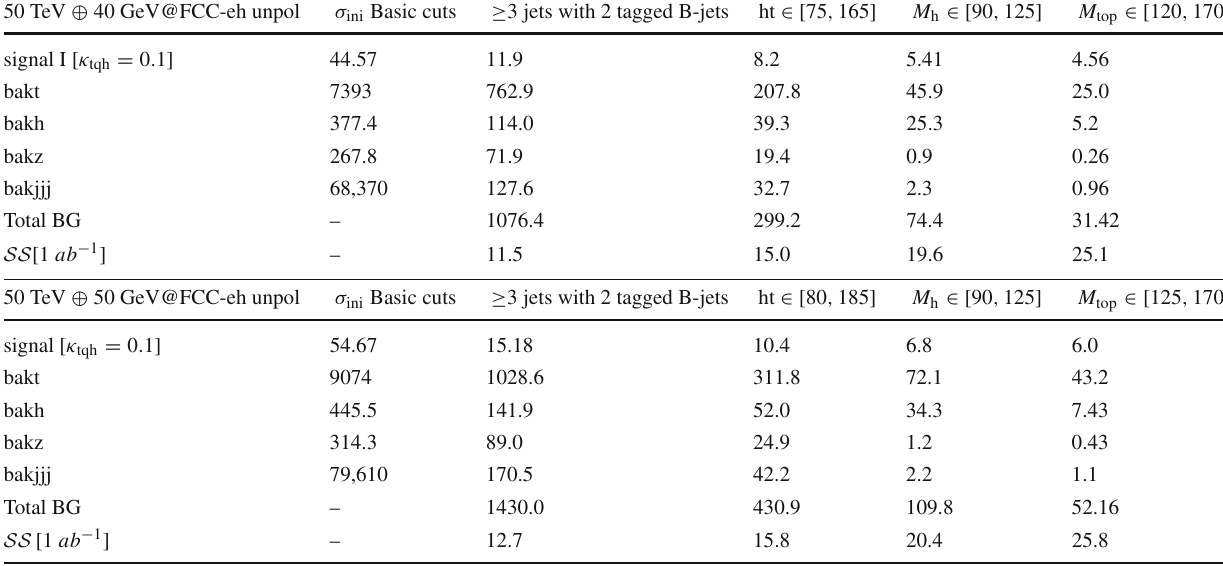
Table 4 Cross sections (in units of fb) and significance depending on the cut flows for signal I e − p → ν e ¯ t → ν e h ¯ q → ν e b ¯ b ¯ q ( κ tuh = 0 . 1) and backgrounds at the 50 TeV ⊕ 40 GeV@FCC-eh and 50 TeV ⊕ 50